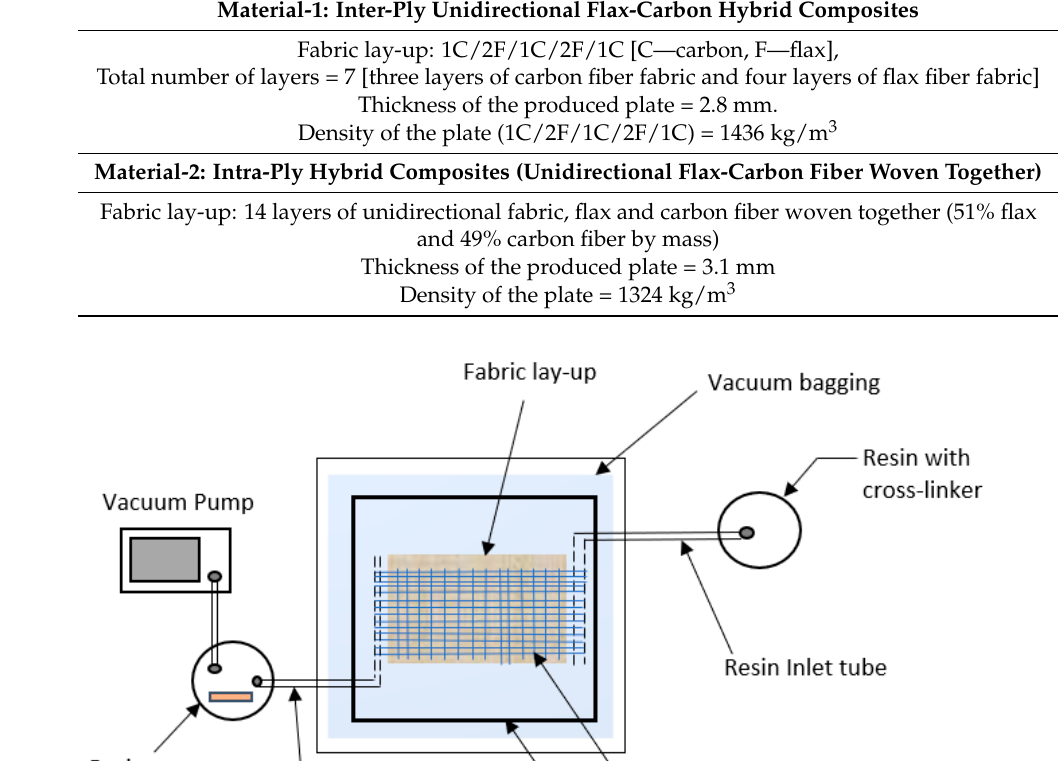
Table 1. Properties and lay-up of produced inter-ply and intra-ply hybrid composites. Material-1: Inter-Ply Unidirectional Flax-Carbon Hybrid Composites